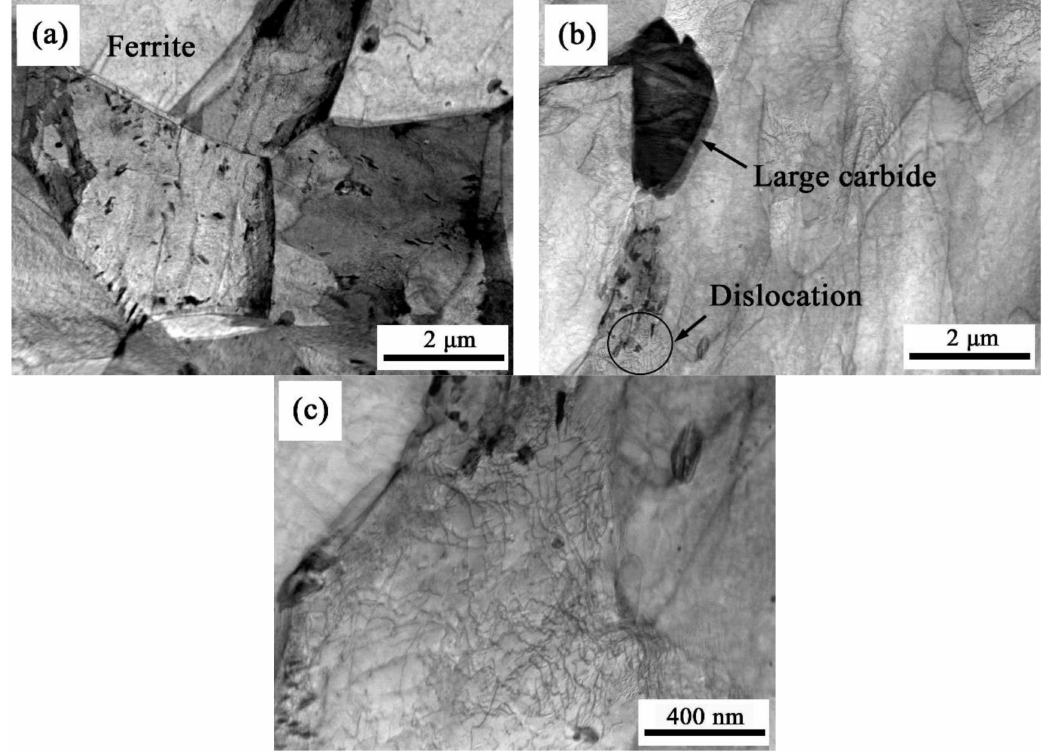
Figure 14. TEM micrograph ( a ), ( b ) and ( c ) showing the CGHAZ microstructure of sample #2; ( c ) is magnified photograph of circled region in ( b